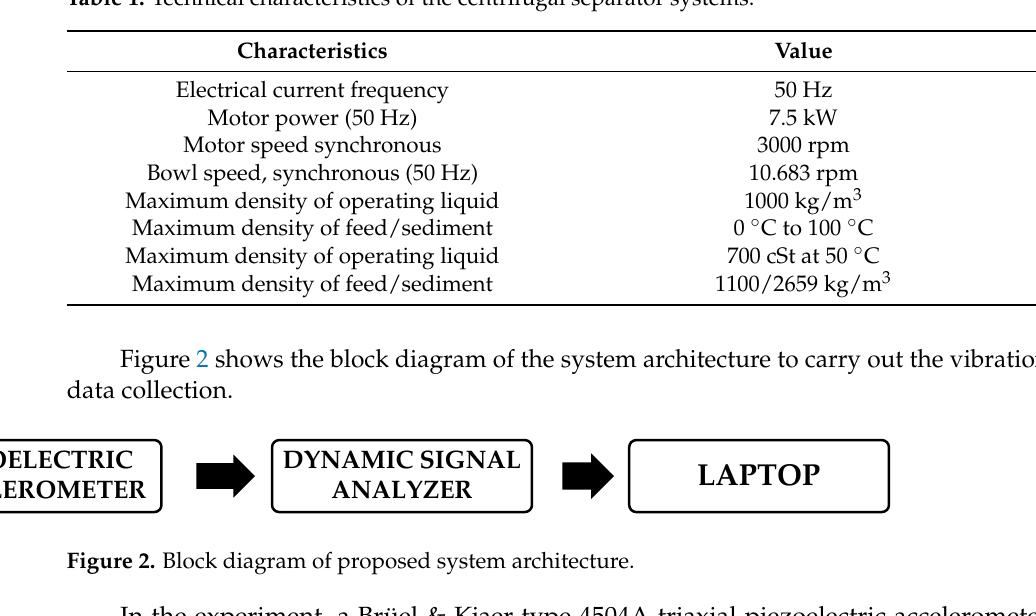
Figure 2. Block diagram of proposed system architecture.